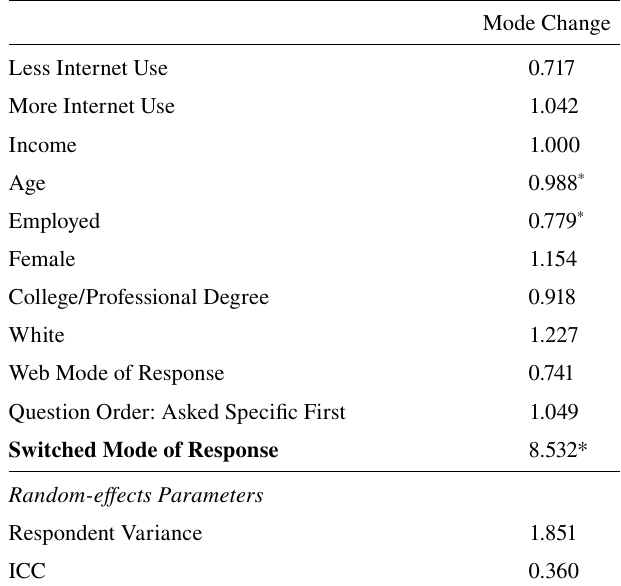
Multilevel Odds Ratio Estimates for Change in Mode Preferences Mode